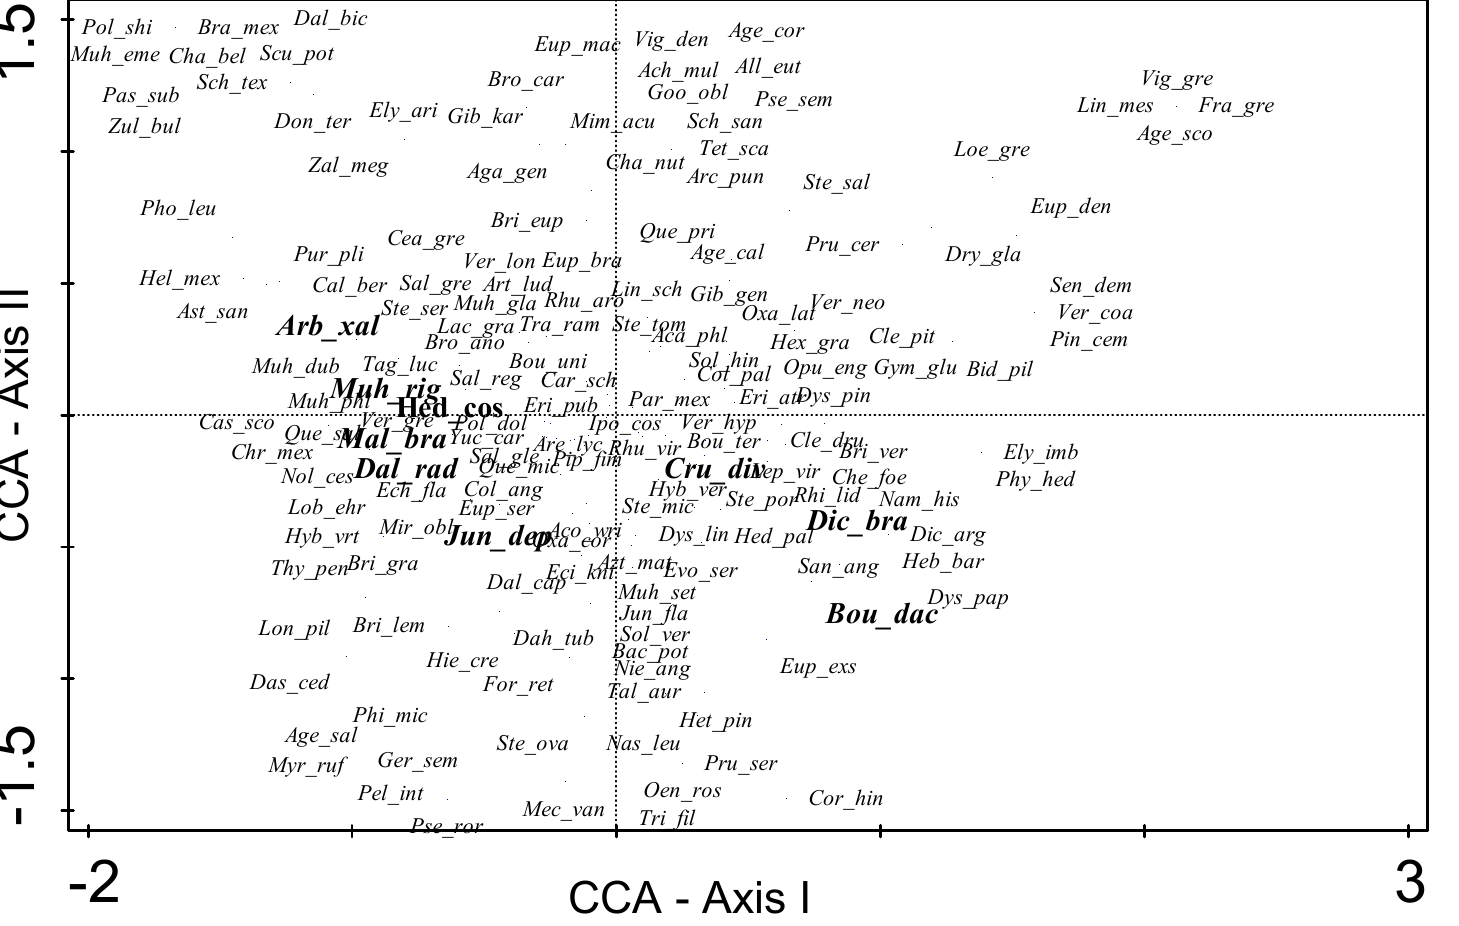
Figure 4. Canonical Correspondence analysis axes I and II with the species coordinates. Species names in bold are indicator species for grazing or control plots (negative scores with respect to axis I are for control plots while positive scores are for grazed plots). Species names use the three first letters of the genus, followed by the first three letters of the specific epithet from Appendix A.